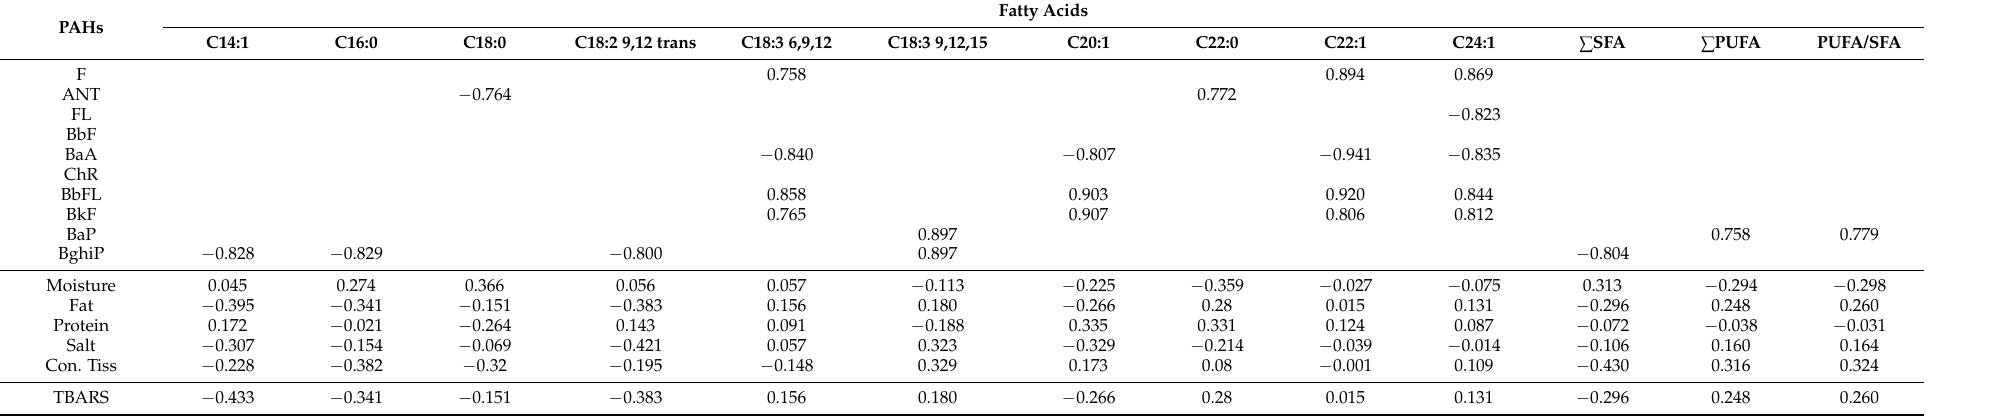
Table 8. Correlation coefficients between the fatty acid profile of raw burgers and PAHs of grilled